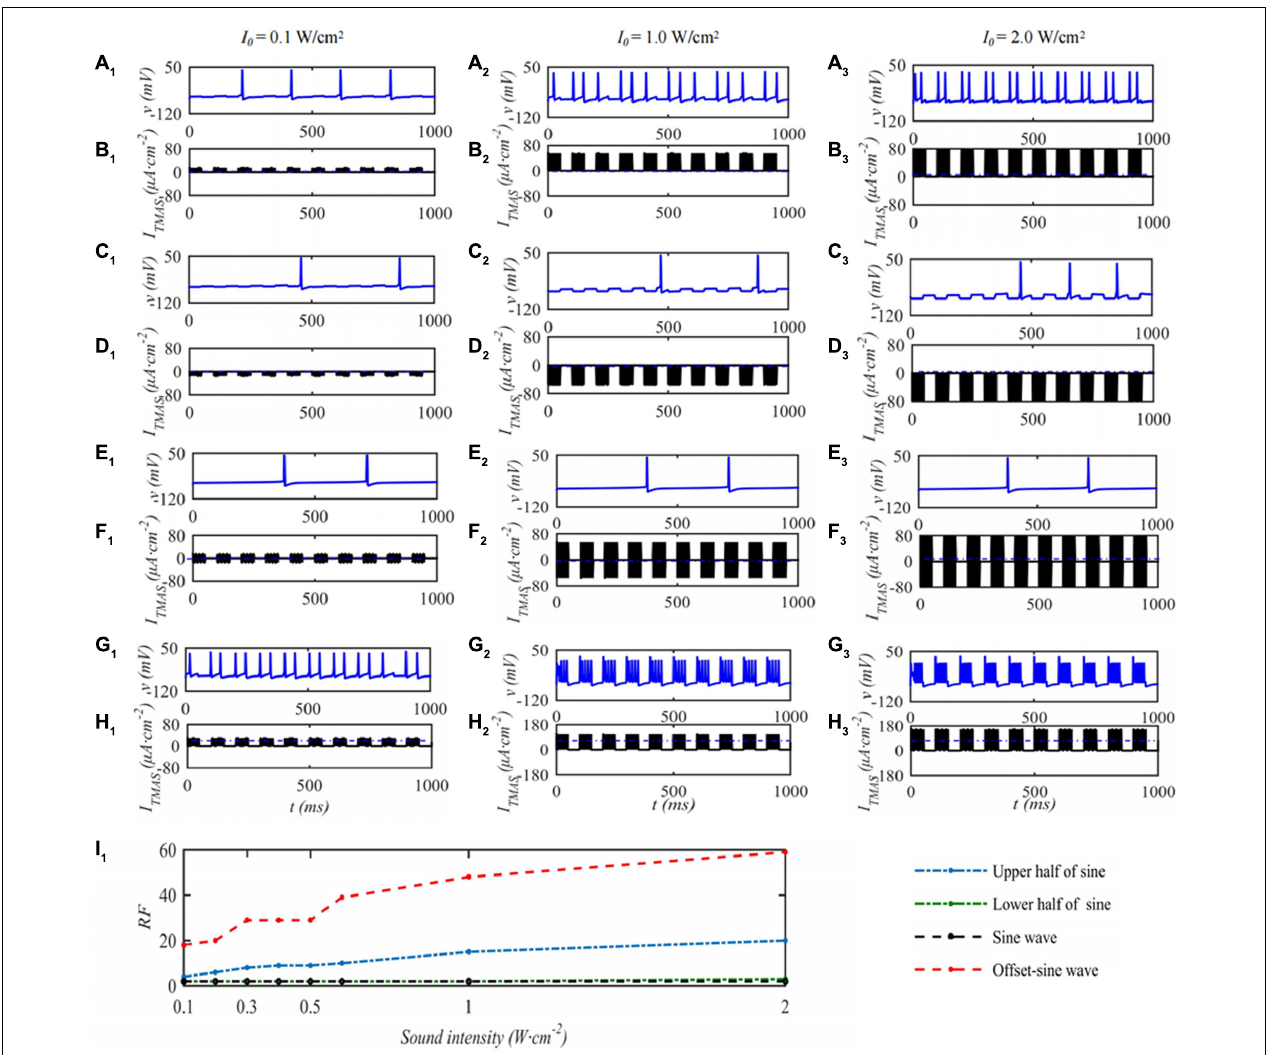
FIGURE 5 | The influence of TMAS input sound intensity on a single STN membrane firing. Columns 1–3 ultrasonic input sound intensity I 0 = 0.1, 1.0 and 2.0 W · cm - 2 , rows 1–4 are the upper, lower half sine wave, sine wave and offset sine wave stimulation. The blue and black curves are STN membrane potential and the TMAS-induced current, (I 1 ) is the curve of STN neuron firing rate versus TMAS input sound intensity ( f = 0.5 MHz, f s = 10 Hz, T 1 / T s = 50%, B = 0.3